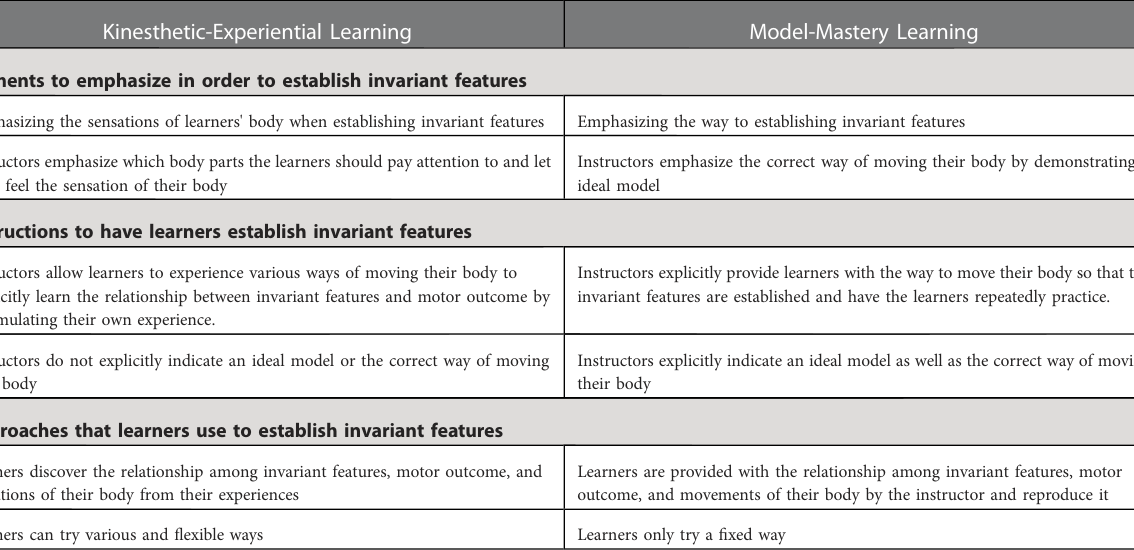
TABLE 1 Two types of learning methods for skill acquisition; Kinesthetic-Experiential Learning and Model-Mastery Learning methods